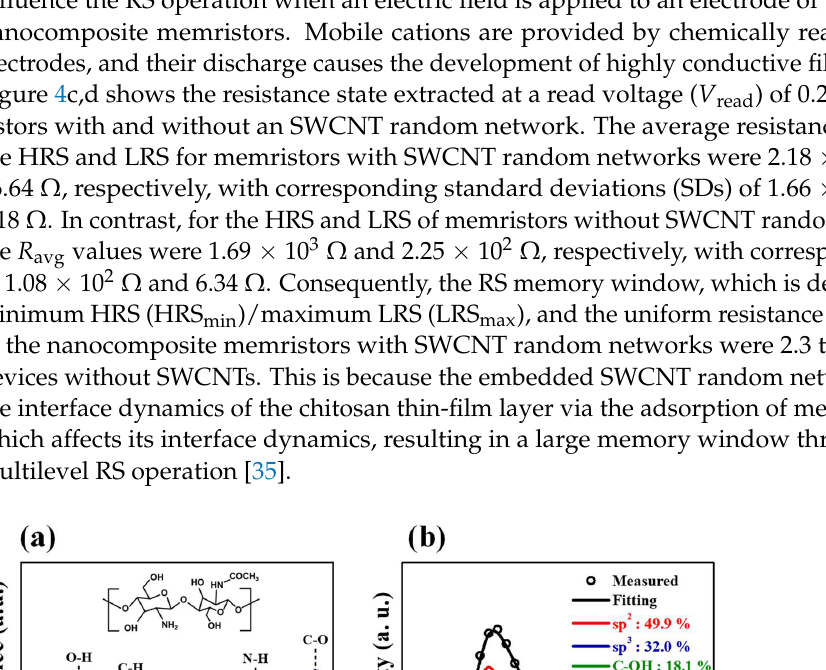
0.2 V for memristors with and without an SWCNT random network. The average re- 2.18 × 10 3 Ω and 96.64 Ω, respectively, with corresponding standard deviations (SDs) of 1.66 × 10 2 Ω and 3.18 Ω. In contrast, for the HRS and LRS of memristors without SWCNT